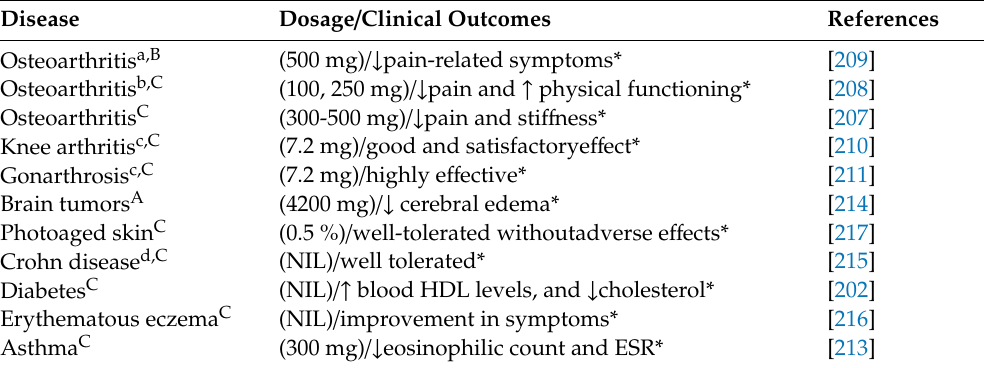
Table 2. Application of boswellic acid in di ff erent phases of human clinical